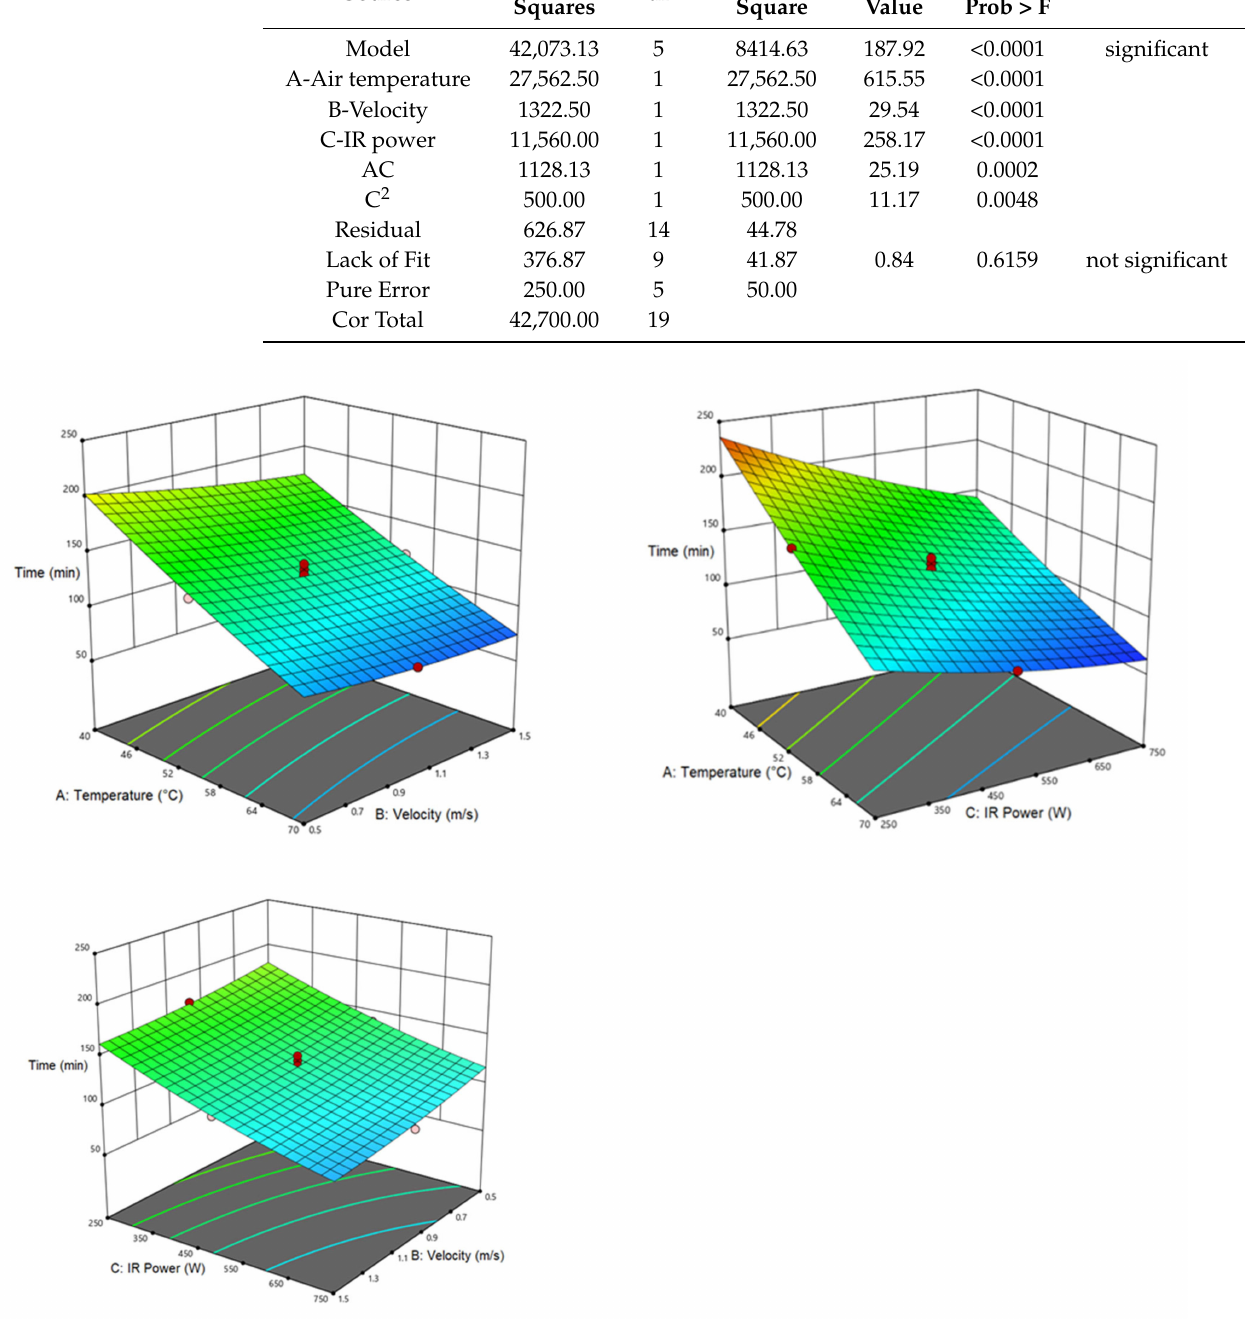
Figure 1. Interaction of air temperature/air velocity, air temperature/IR power, and IR power/air velocity on drying time of